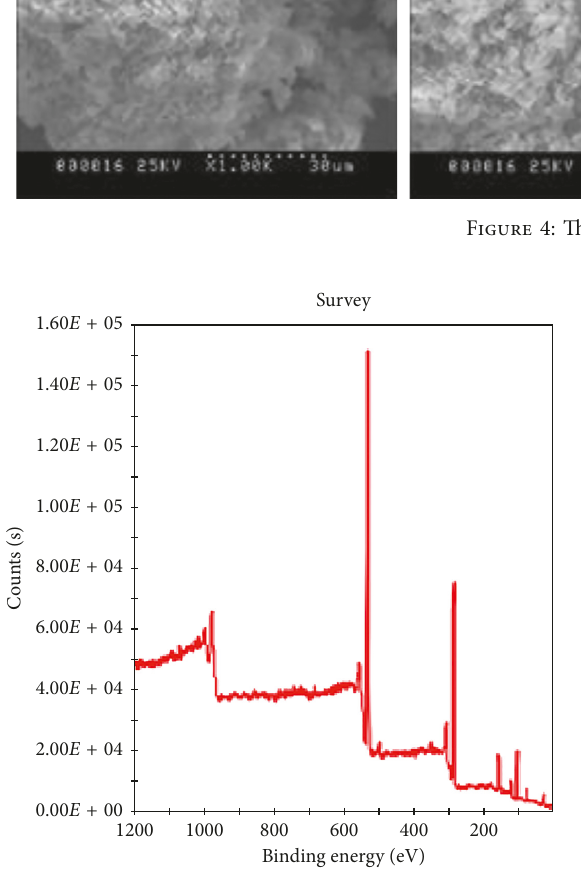
Figure 5: XPS of oil shale